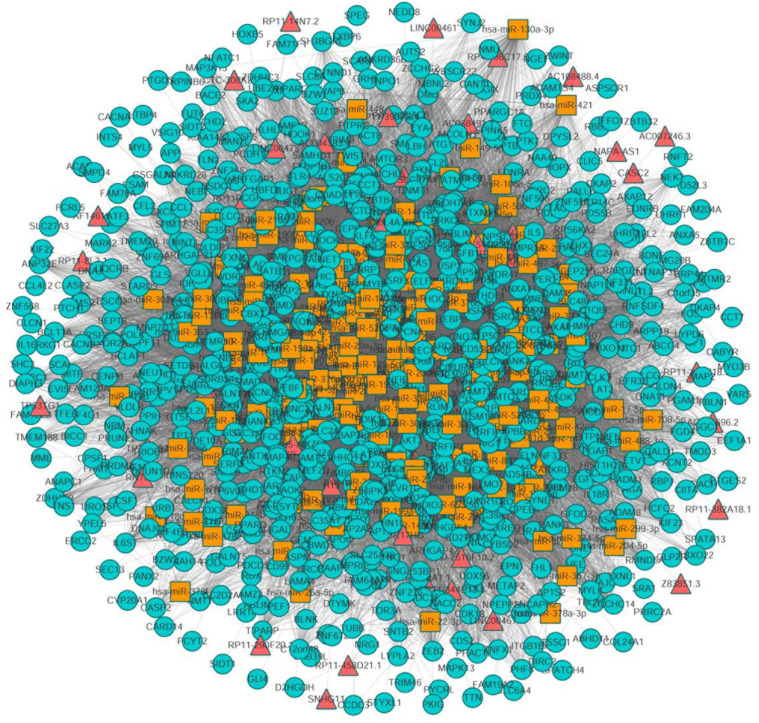
The view of global triple network. The blue, red and yellow nodes represented mRNAs, lncRNAs, and miRNAs, respectively. There were 192 miRNAs, 41 lncRNAs, 775 mRNAs, and 24799 edges in the network.